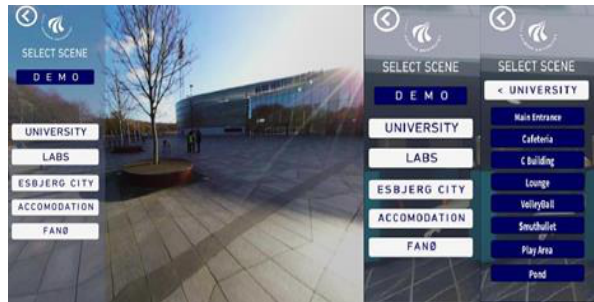
Figure 2 . Application interface with the five main categories, and sub-menu with the viewable locations for one of the main categories.